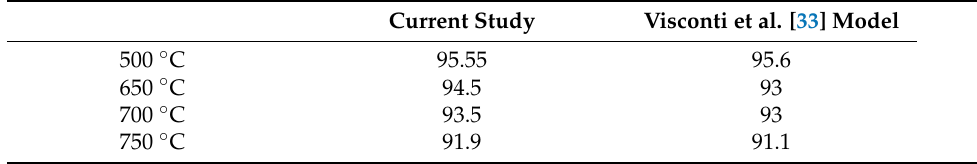
Table 5. Comparison of carbon content (wt%) in biochar.